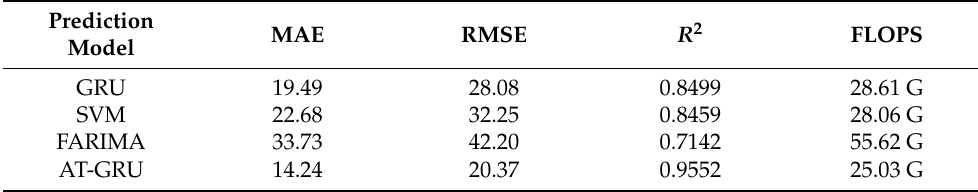
Figure 12. Model convergence performance diagram.